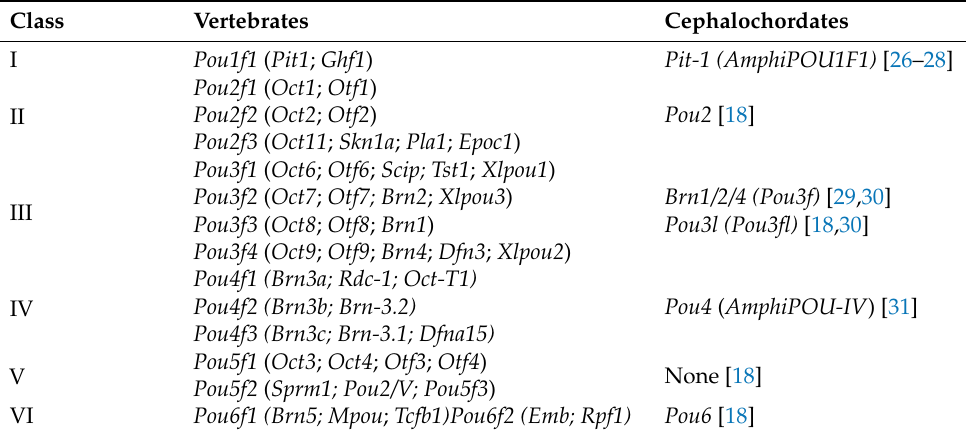
Table 1. POU family members in vertebrates and